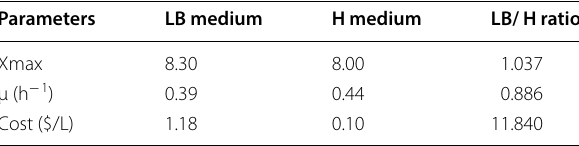
Table 7 Ratio between the optimized medium (H medium) and LB